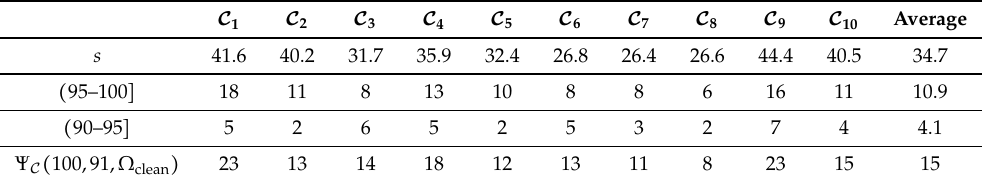
Figure 2. ShuffleDetect performed on 100 clean (ancestor) images with 100 permutations. Table 5. For each C k , the number (=percentage) of clean ancestors A p q declared adversarial for s out of 100 permutations. The first row shows the average number of permutations for which this occurs. The last row, the sum of the two previous ones, provides an estimate of the FPR, which serves as a lower bound for ShuffleDetect per CNN via the assessment of Ψ C ( 100,91, Ω clean )